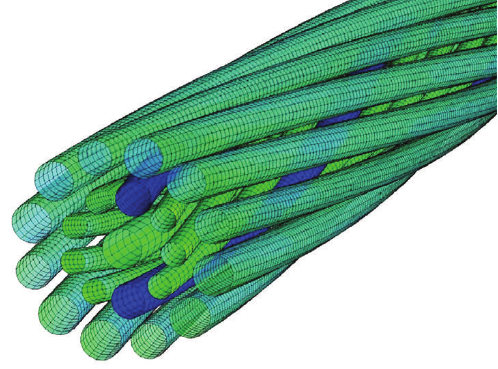
Figure 4: Typical finite element